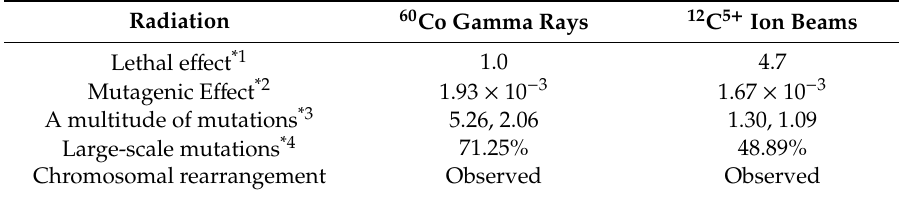
Table 3. Characteristics of radiation-induced mutations in Aspergillus oryzae